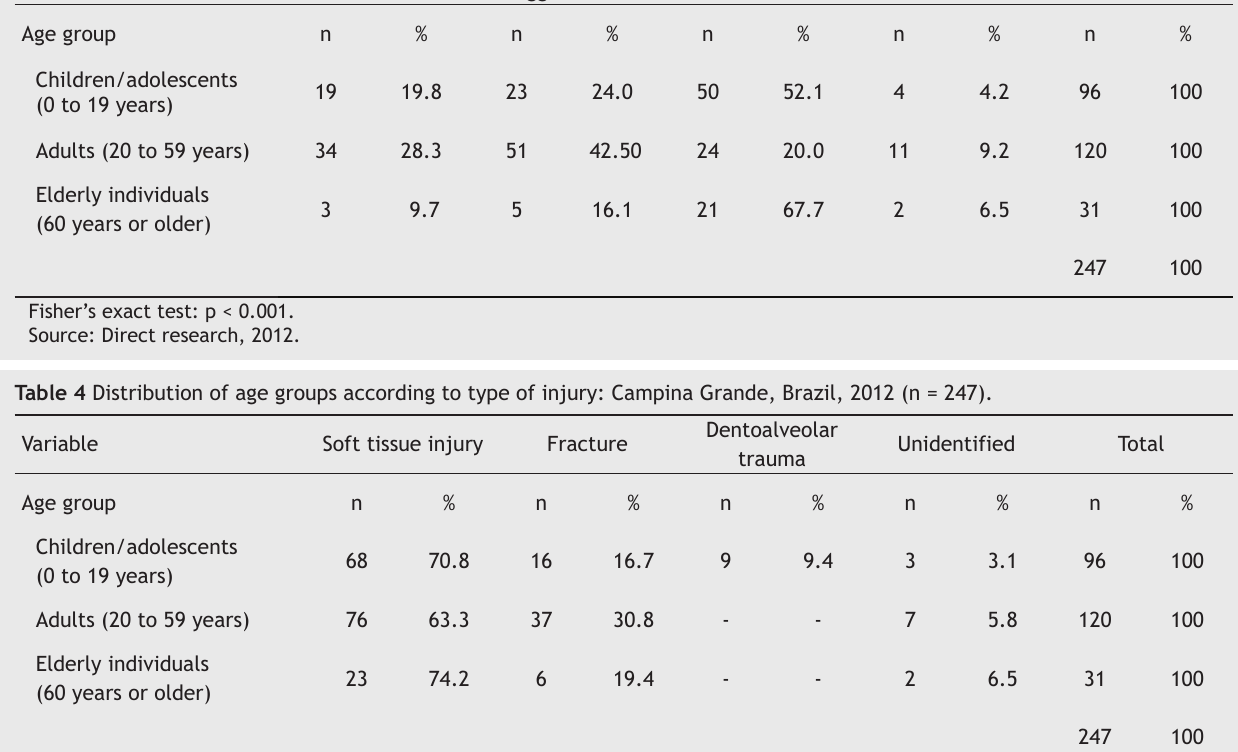
Table 3 Percentage distribution of age groups and year of occurrence of facial trauma: Campina Grande, Brazil, 2012 (n = 247). Variable